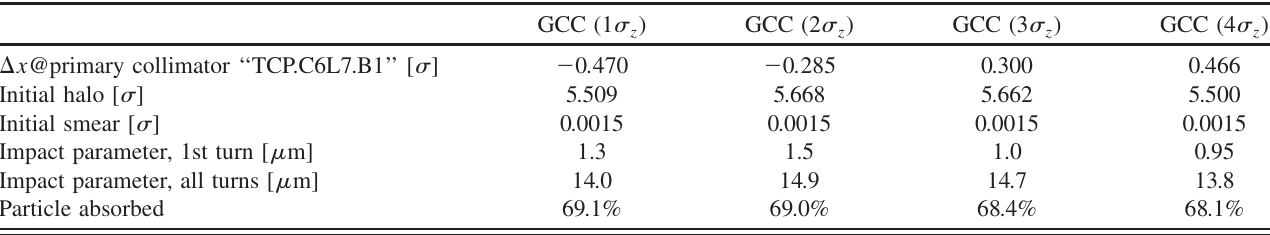
TABLE II. Collimation simulation parameters for different cases, with the 800-MHz global crab